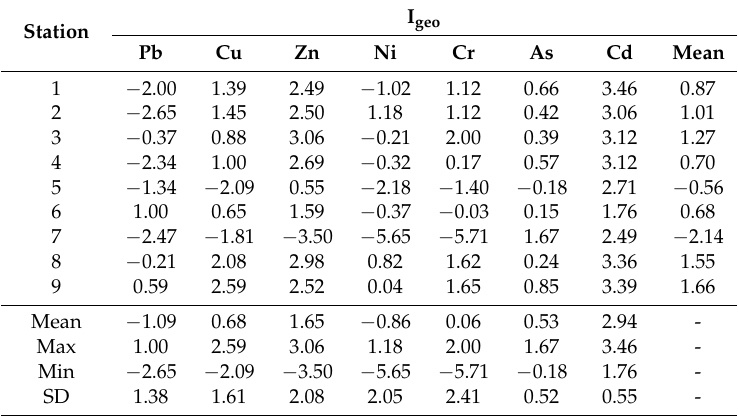
Table 3. Geoaccumulation index values for heavy metals in sewage sludge.